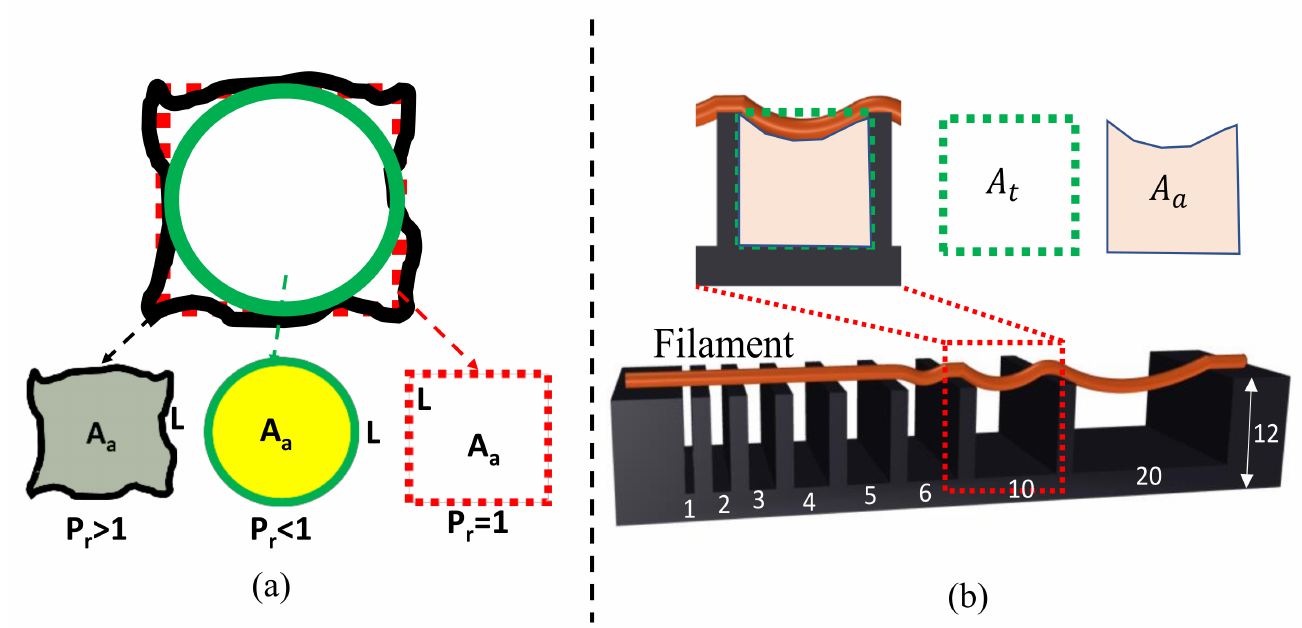
Figure 3. ( a ) Representation of printability, and ( b ) Theory of Collapse